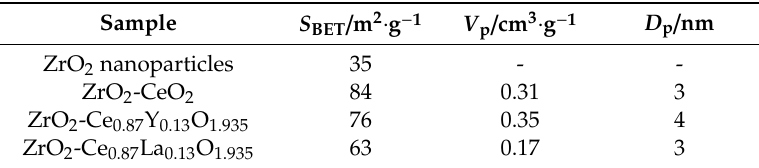
Table 3. Textural parameters estimated for the commercial ZrO 2 nanoparticles and the fresh undoped and Ln-doped ZrO 2 -CeO 2